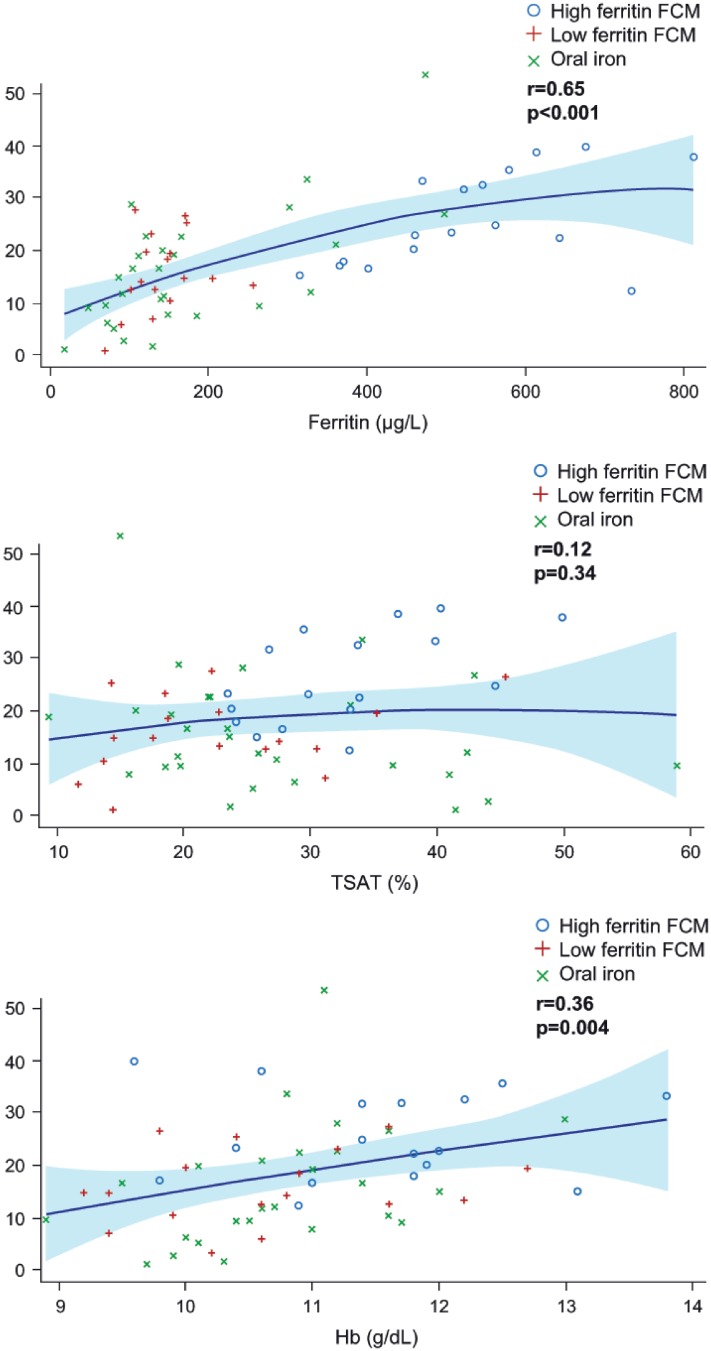
Correlation between hepcidin levels and (a) ferritin level (b) TSAT level (c) Hb level at study endpoint for the hepcidin substudy population.Only values with the same sample date, and obtained prior to the start of alternative anemia therapy, are included. Solid lines indicate the quadratic regression line. Shaded areas indicate 95% CI of the regression line.